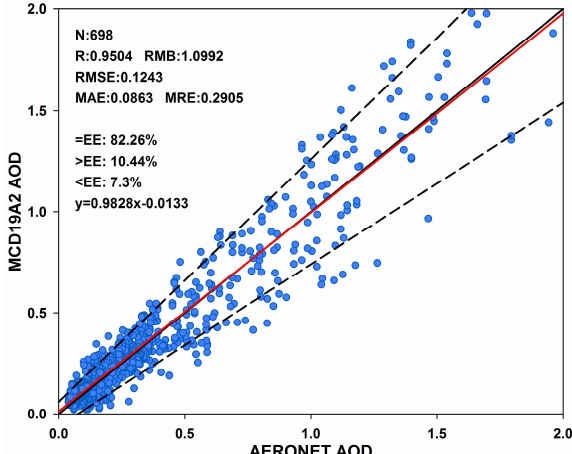
Figure 3. Scatter distribution of AOD point pairs and summary of verification results